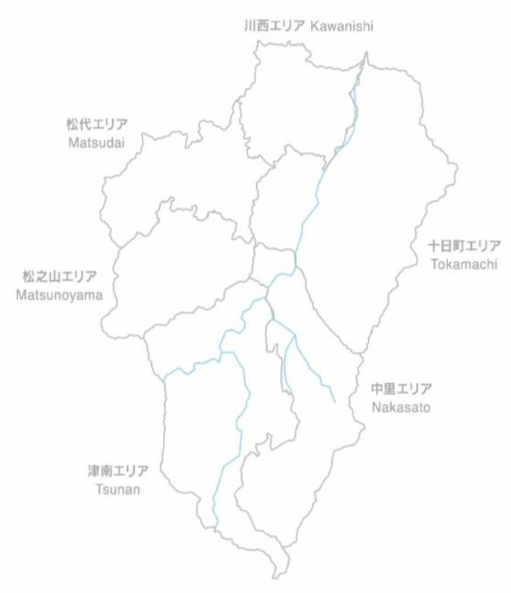
Figure 5. The Echigo–Tsumari Art Triennial (ETAT) areas.